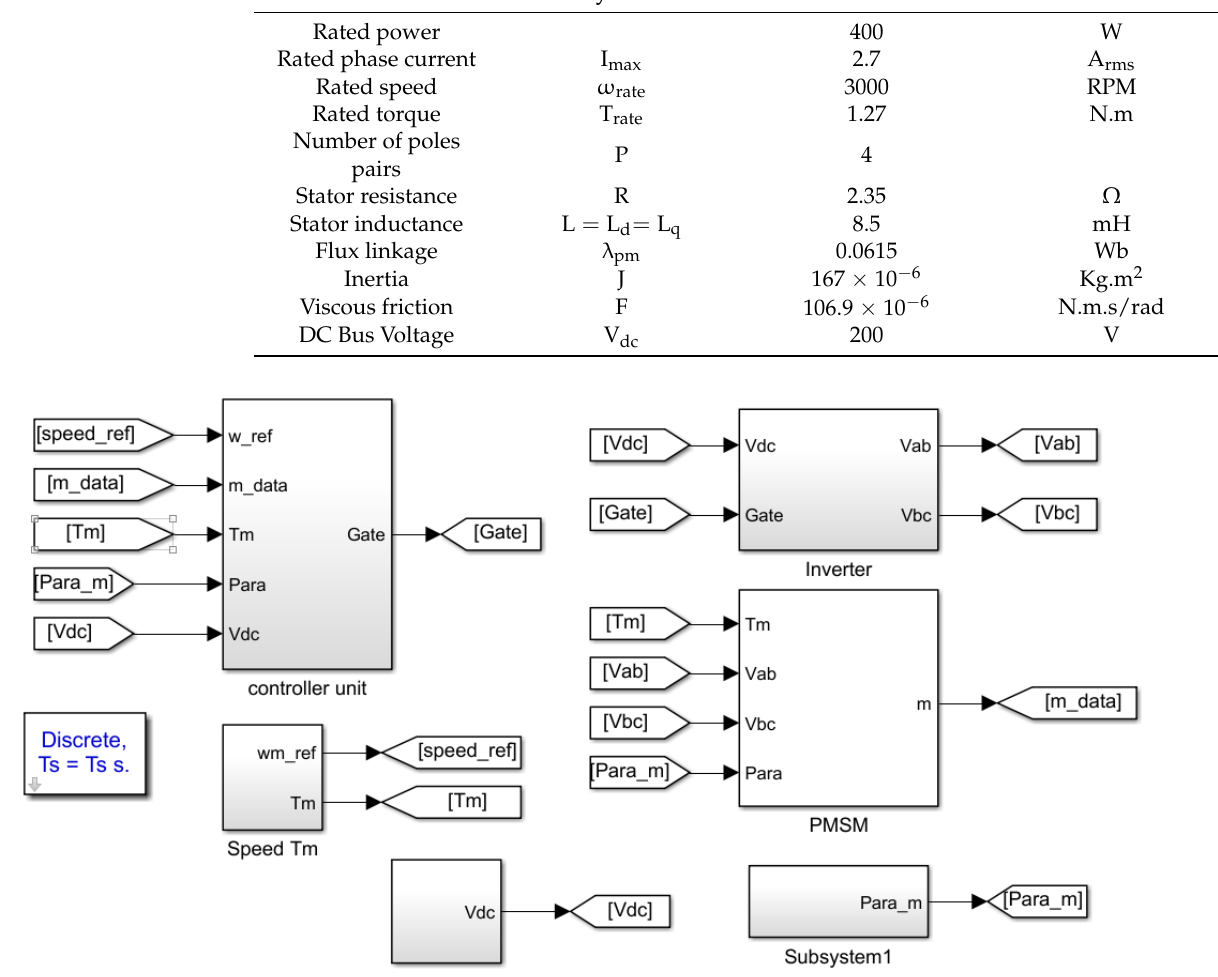
Figure 6. IPMSM control simulation model. Table 1. PMSM parameters.